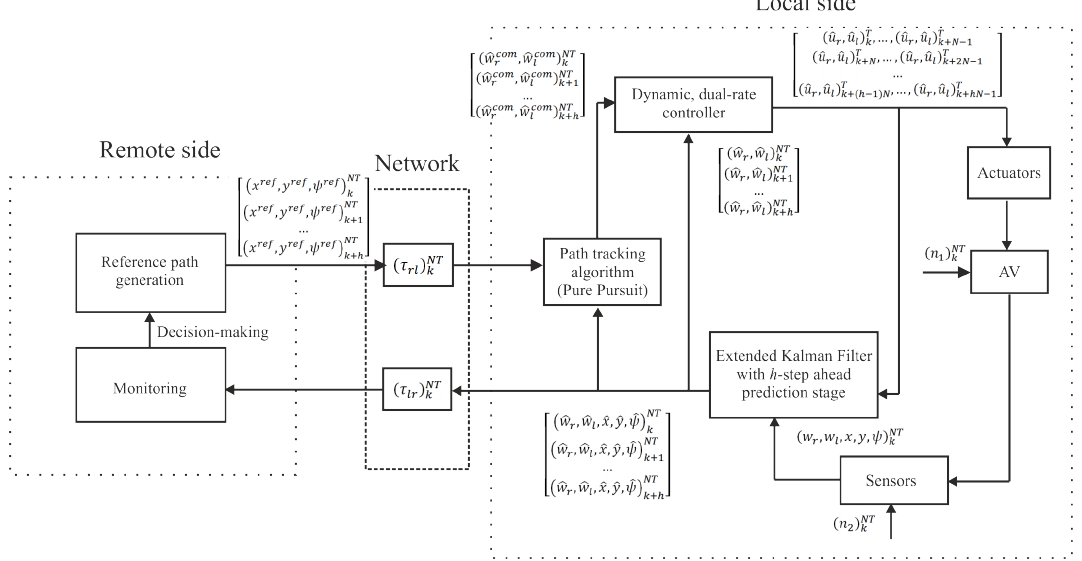
Figure 1. Remote control structure for an autonomous